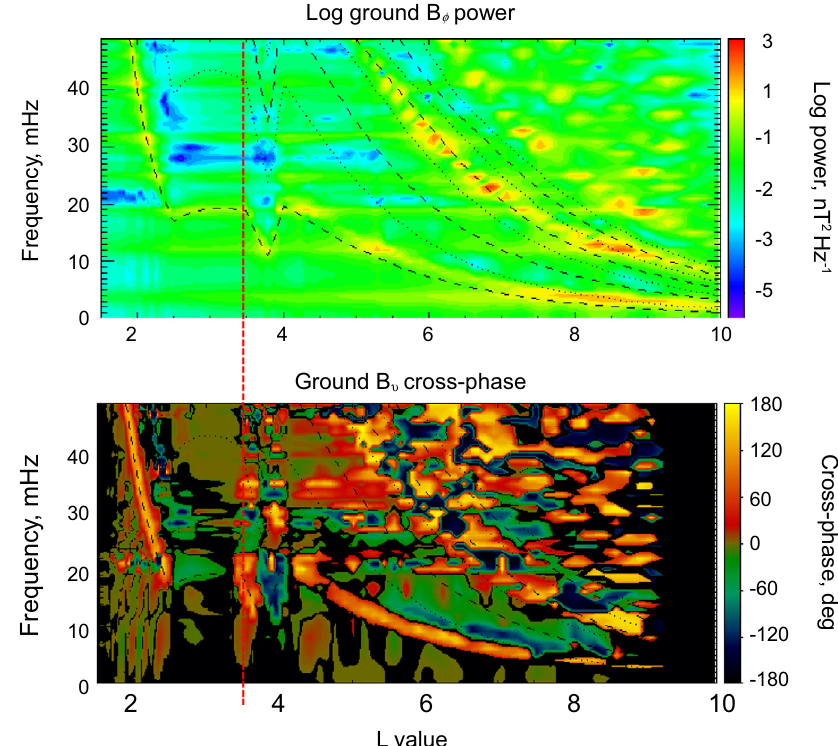
Fig. 11. Top: model ground level north-south component power spectral density. Alternate dashed and dotted lines denote odd and even harmonics, respectively. Bottom: model ground-level cross-phase between stations separated by 2 degrees in latitude. Vertical dotted line denotes region where three alternating cross-phase bands